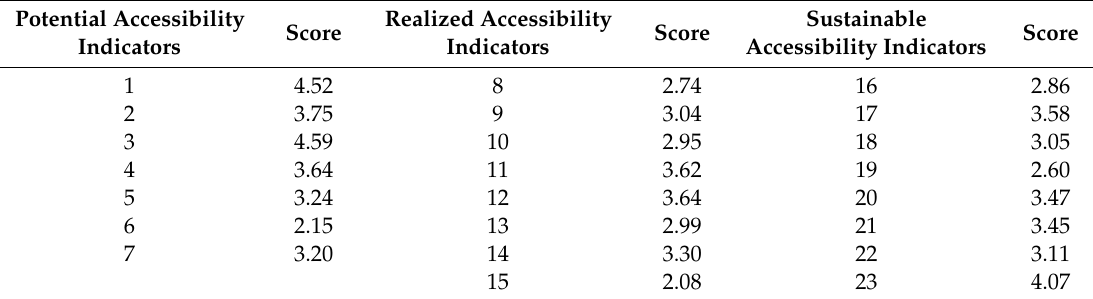
Table 9. Score of indicators of the accessibility of healthcare services for the